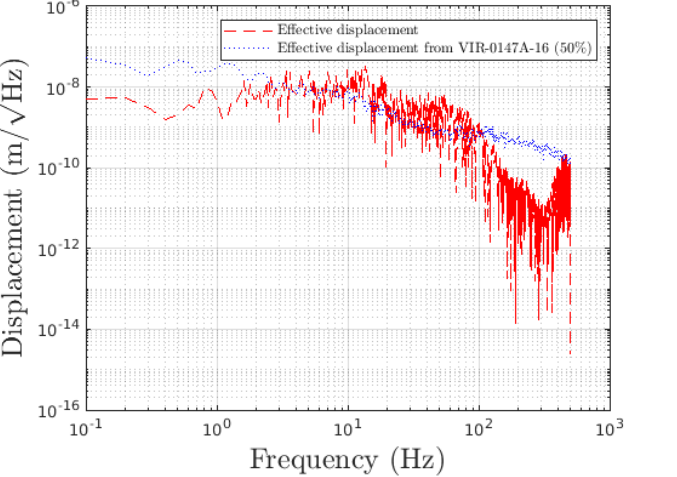
Figure 15. Comparison of the cryobaffle effective displacement obtained by the two methods de- scribed in Sections 5.1 (dashed red curve) and Sections 5.2 (dotted blue curve).